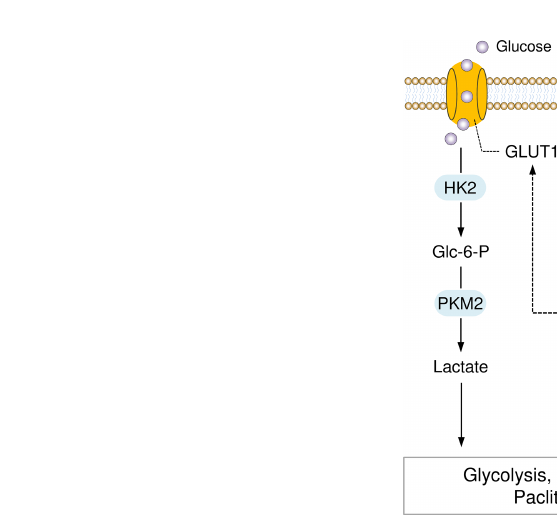
FIGURE 10 | Graphical Abstract showing that the LncRNA TMPO-AS1 Regulates Glycolysis and Paclitaxel Resistance in EC Cells by Affecting the MiR-140/MiR- 143-GLUT1